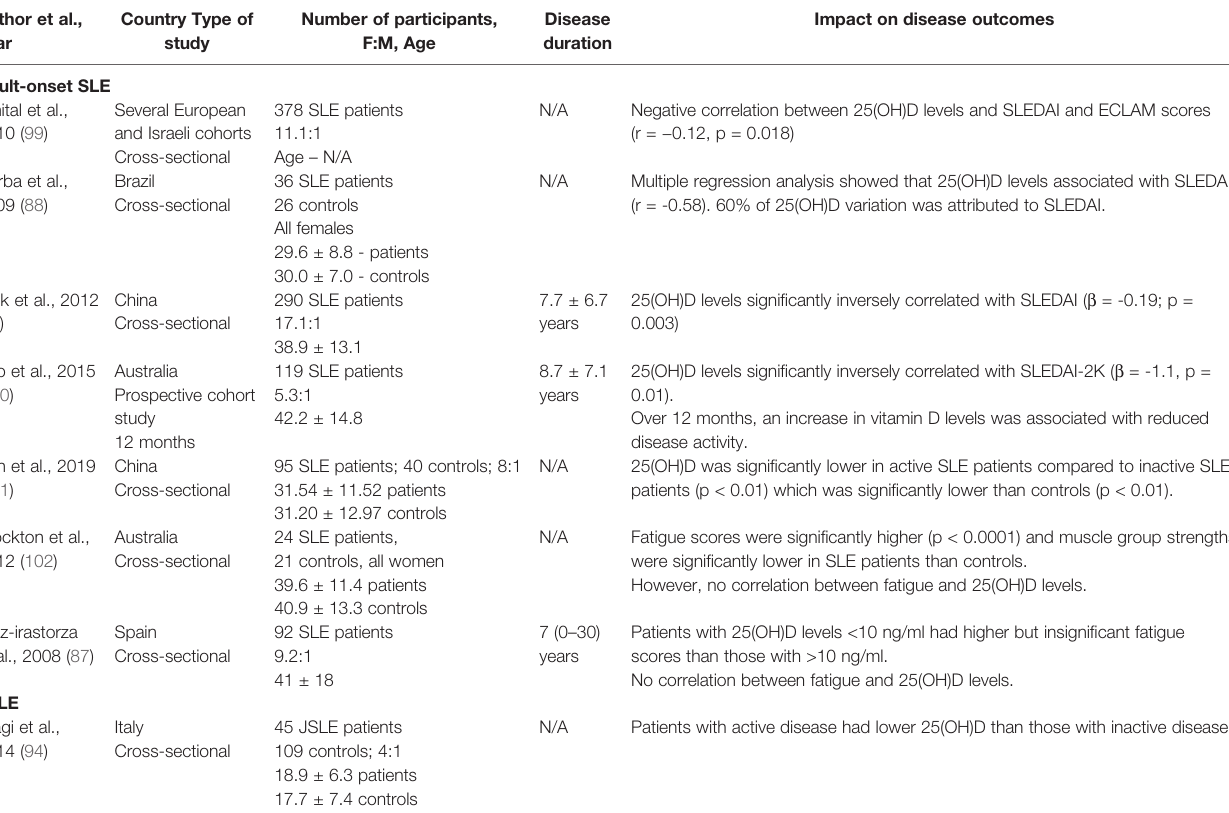
TABLE 4 | Impact of vitamin D concentration on JSLE and adult-onset SLE